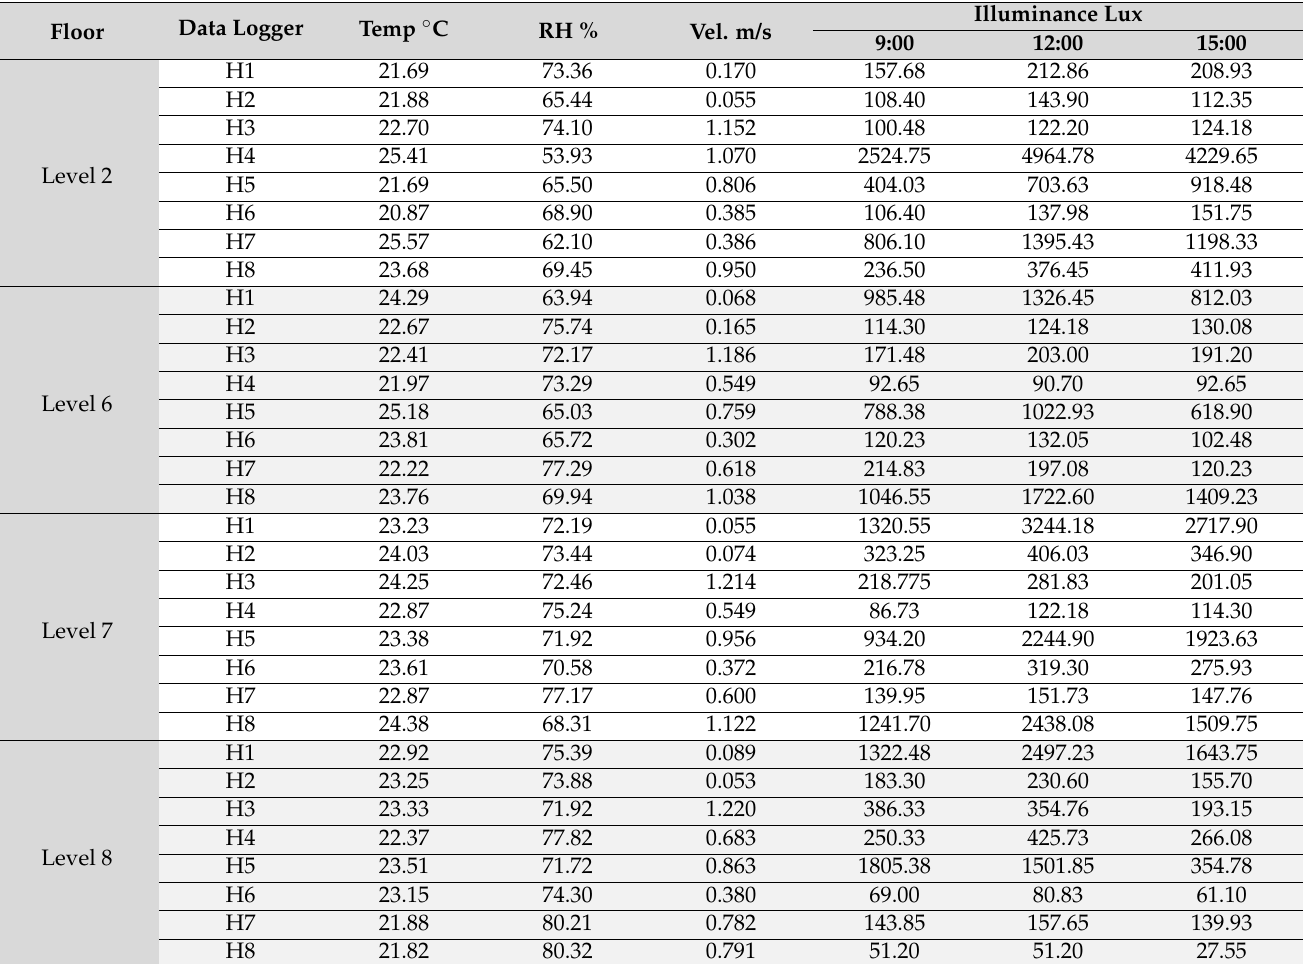
Table 8. Average readings of all physical measurements at all